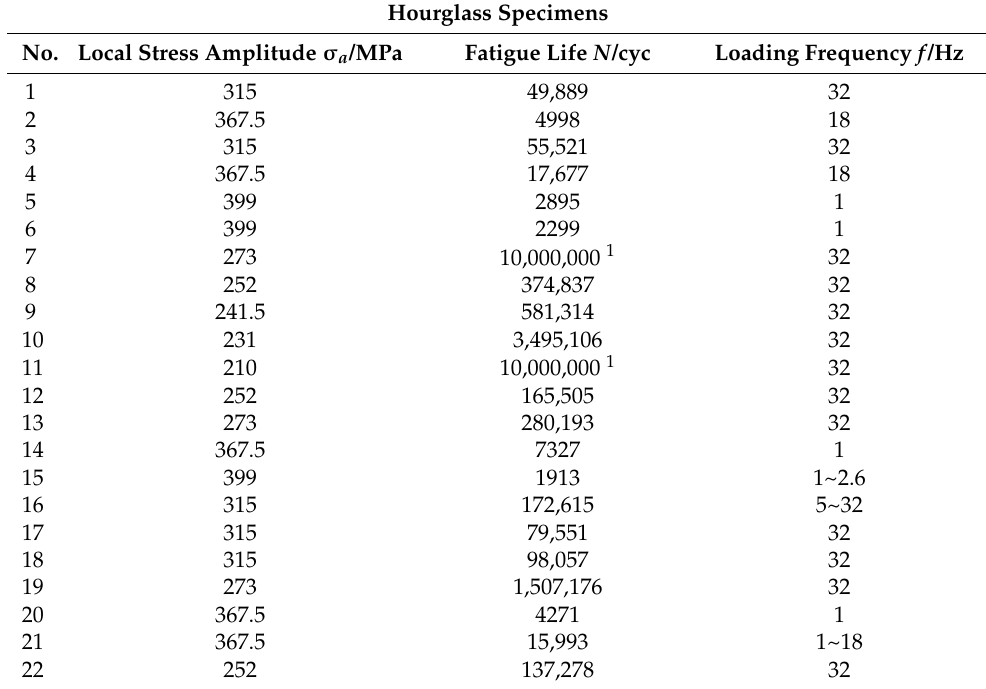
Figure 3. S-N data of the tested specimens, in which the arrows denote the unbroken specimens at the associated cycles. ( a ) Hourglass specimens; ( b ) dogbone specimens. Table 1. Loading information of the tested specimens.